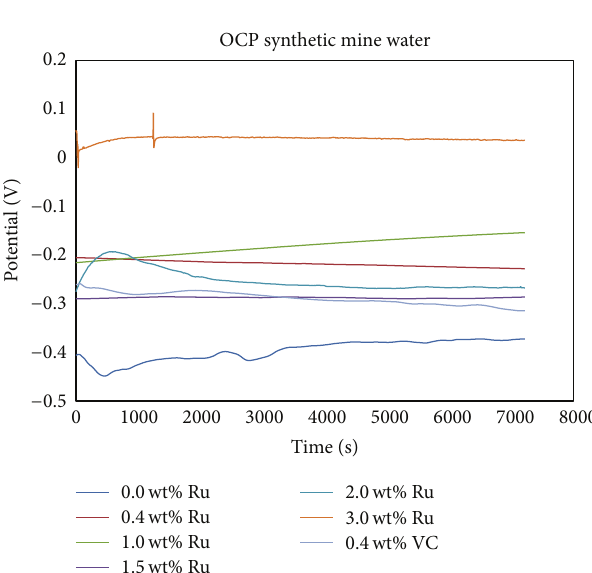
Figure 6: Open circuit potential results of the samples exposure to synthetic mine